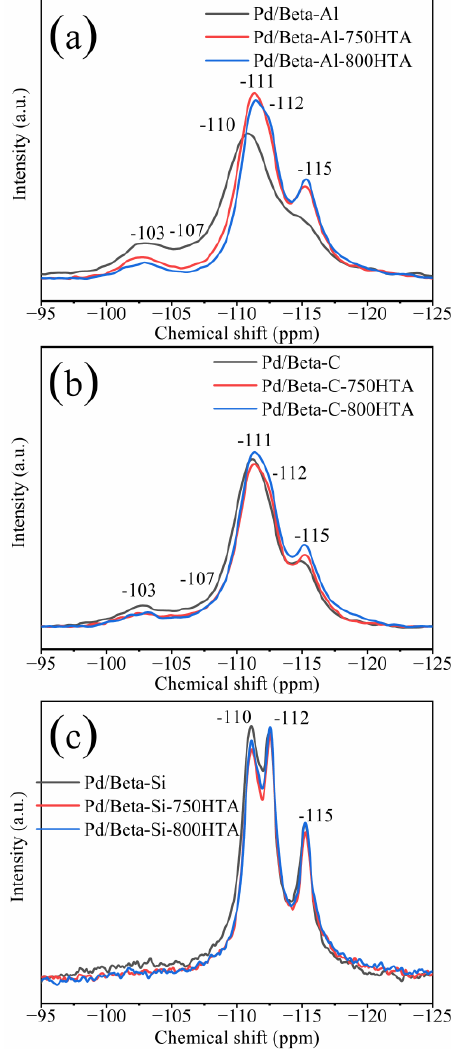
Figure 3. 29 Si NMR spectra for the ( a ) Pd/Beta-Al, Pd/Beta-Al-750HTA and Pd/Beta-Al-800HTA; ( b ) Pd/Beta-C, Pd/Beta-C-750HTA and Pd/Beta-C-800HTA; and ( c ) Pd/Beta-Si, Pd/Beta-Si-750HTA and